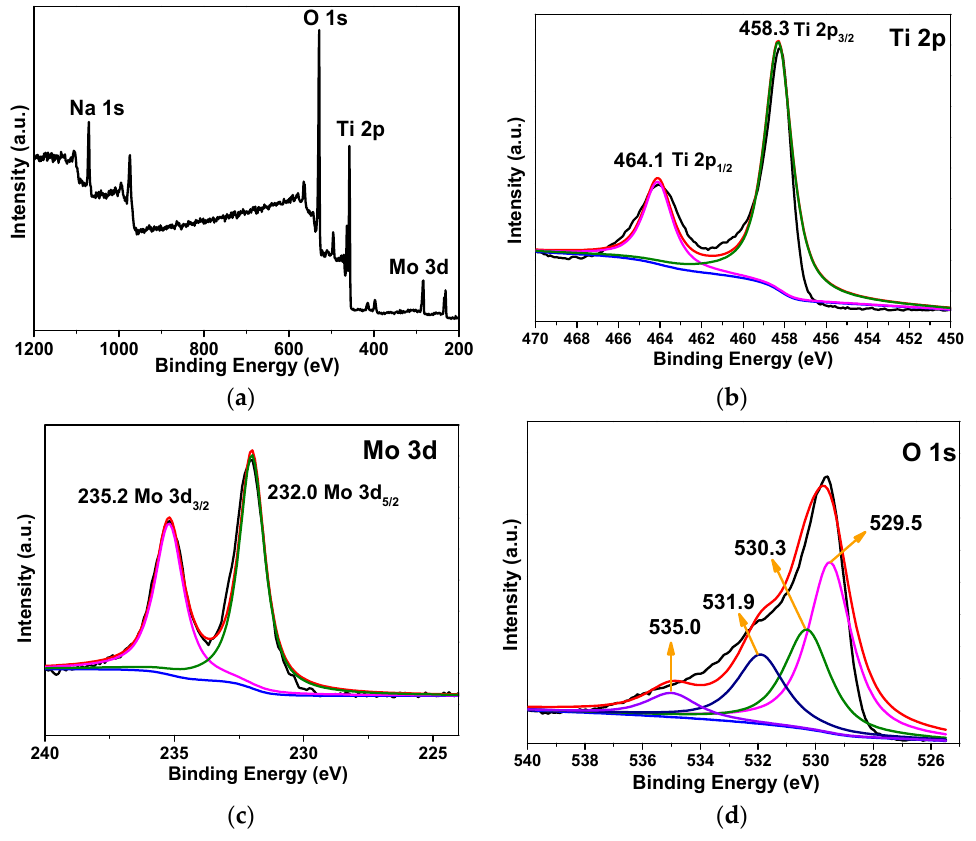
Figure 5. ( a ) Survey XPS spectrum and high-resolution XPS spectra of the ( b ) Ti (2p), ( c ) Mo (3d), ( d ) O (1s) regions of the Na 2 MoO4 – 41.4%-TiO 2 nanocomposite.